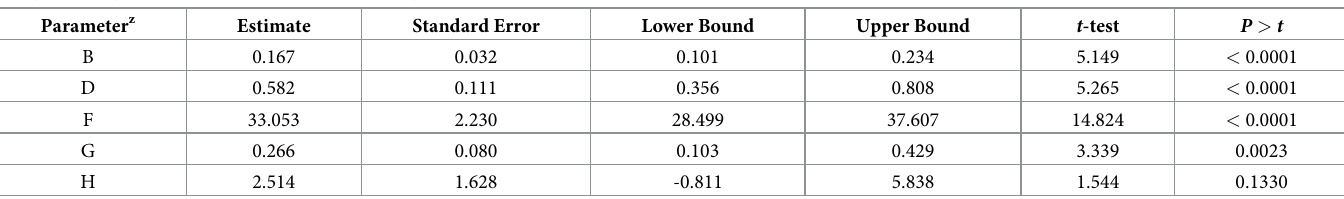
Table 2. Estimated parameter values of Duthie’s model, Eq 1, describing the relative disease severity ( S ’) caused by Xanthomonas arboricola pv. pruni on peach- almond hybrid GF-677 plants based on combined effects of temperature ( t ) and duration of leaf wetness ( w ). In the